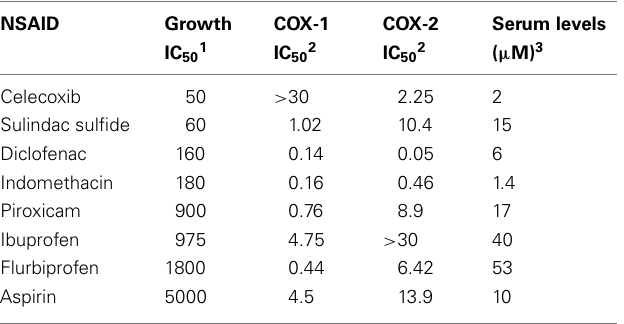
Table 1 | Potency of a panel of NSAIDs to inhibit colon tumor cell growth and cyclooxygenases.